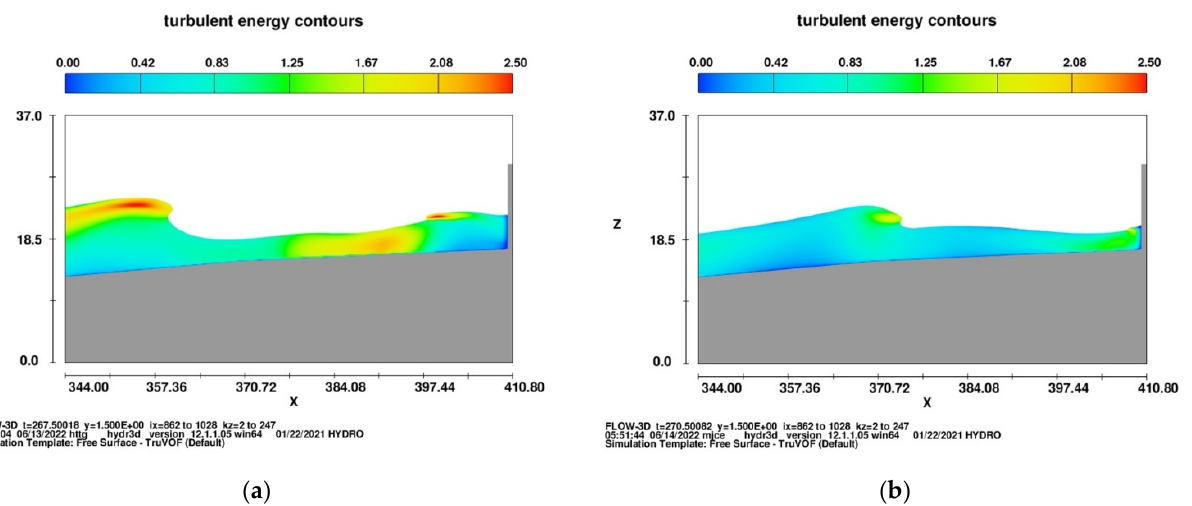
Figure 11. Breaking waves under wind speed 31 m/s. Panel ( a ) TEST_1 and Rc = +11.00 m; panel ( b ) TEST_4 and Rc = +11.00 m.